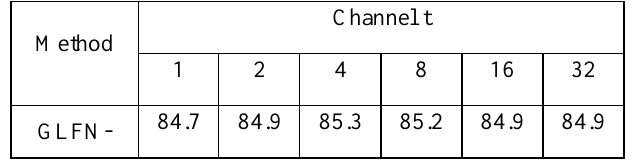
Figure 3. Training procedure for four methods on the SemEVAL-2010 Task 8